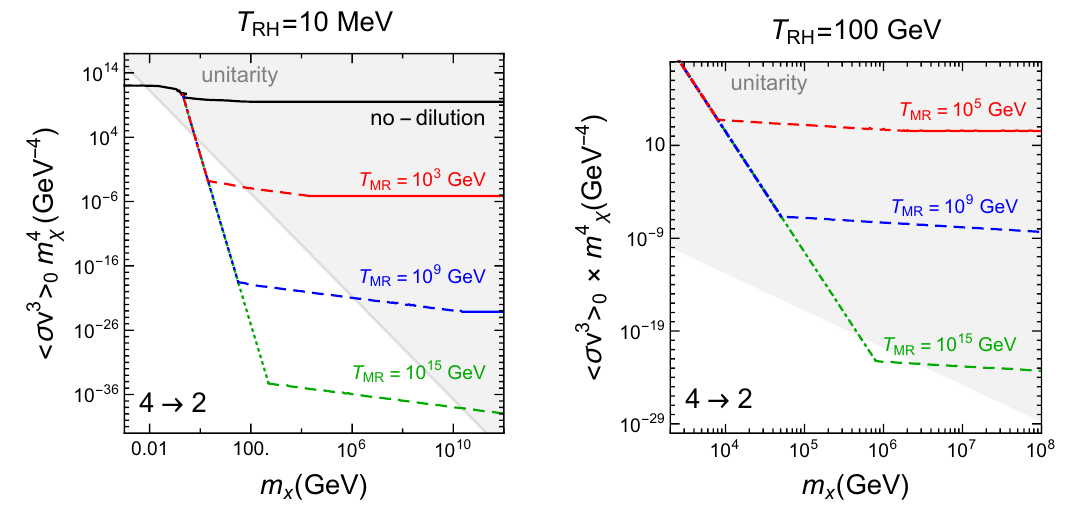
Figure 4 . Same as figure 2, for a scenario in which the dominant number-changing DM annihila- tions are of 4 → 2